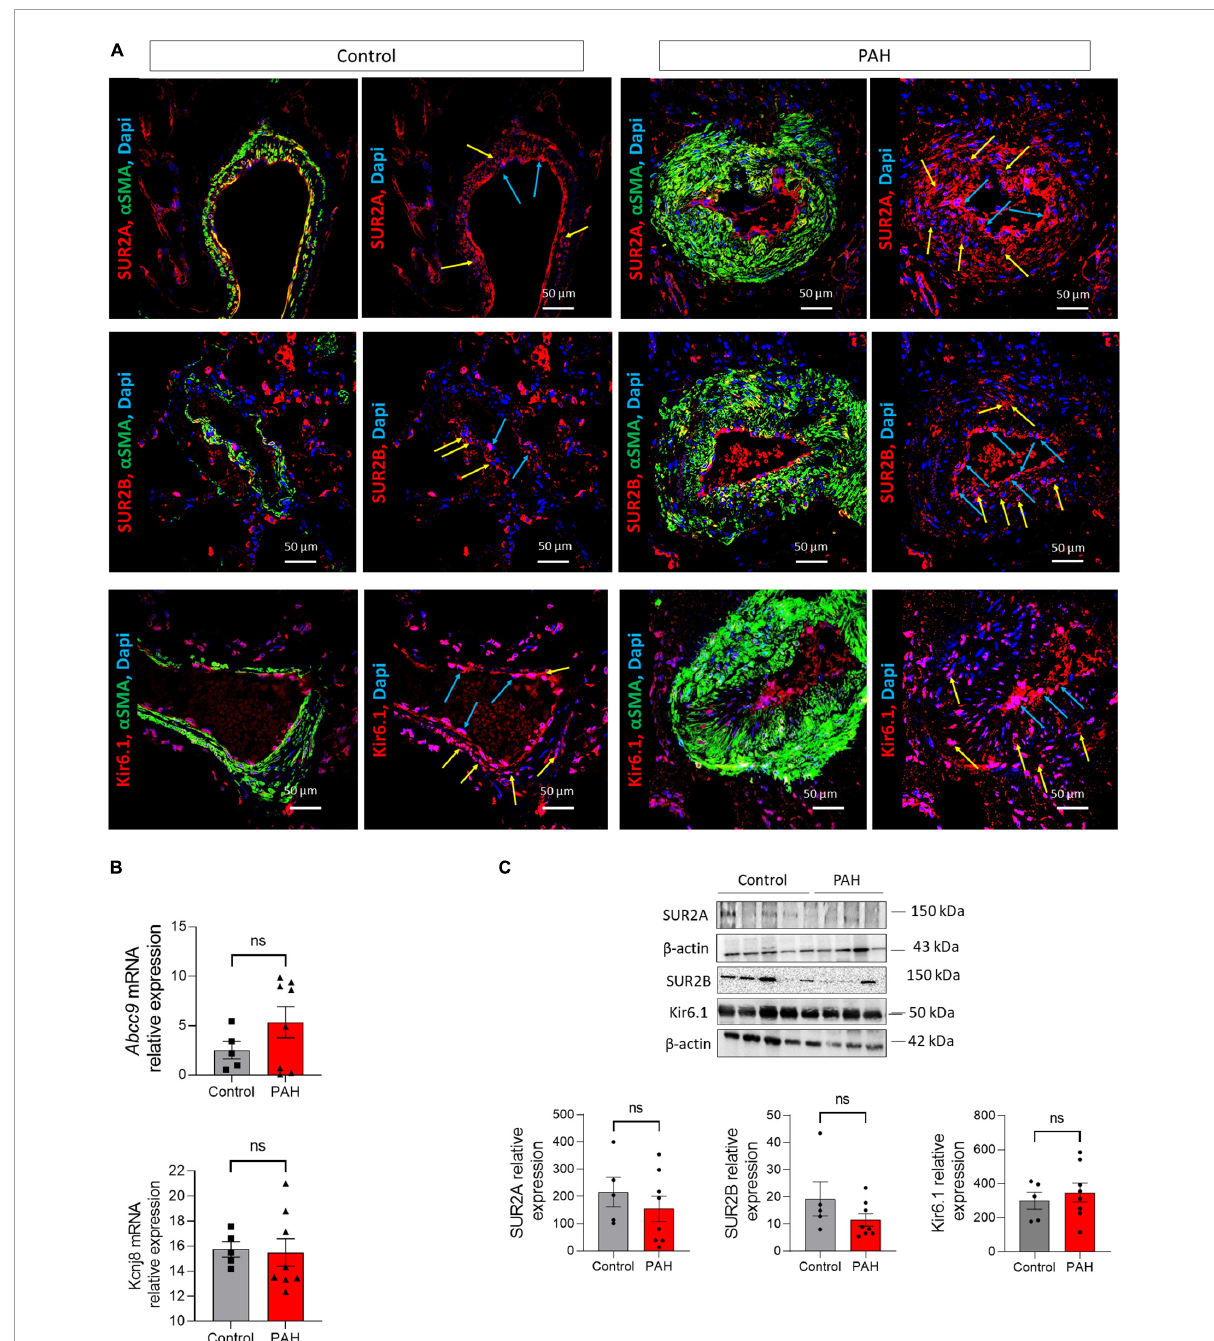
FIGURE1 Expression of SUR2A, SUR2B, and Kir6.1 protein in lungs from control and patients with PAH. (A) SUR2A, SUR2B, or Kir6.1 immunostaining in paraffin-embedded lung sections from controls and patients with PAH; PAEC (blue arrow) and PASMC (yellow arrow) staining is visible. Scale Bar 50 µ m. mRNA expression and representative western blots of ABCC9 (coding for SUR2A and SUR2B) and KCNJ8 (coding for Kir6.1) in the lungs of controls and patients with PAH [ (B,C) , respectively] ( n = 9–12). ns: non-significant vs. control. Two-tailed unpaired Student t -tests assessed the difference between the two